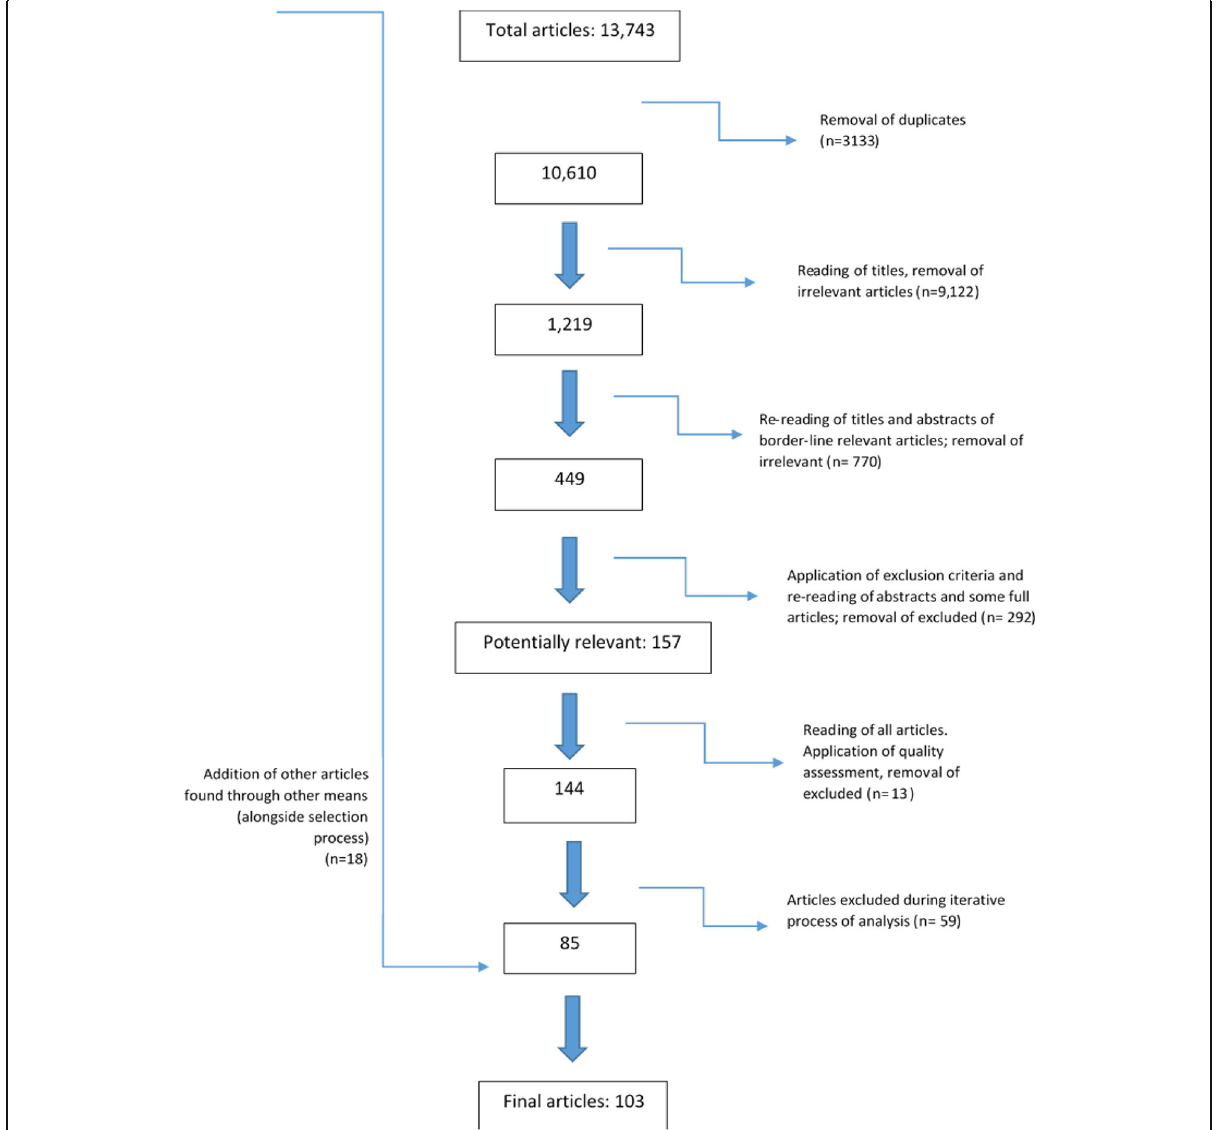
Fig. 1 “ PRISMA ” diagram outlining process of electronic database and other searching (as per